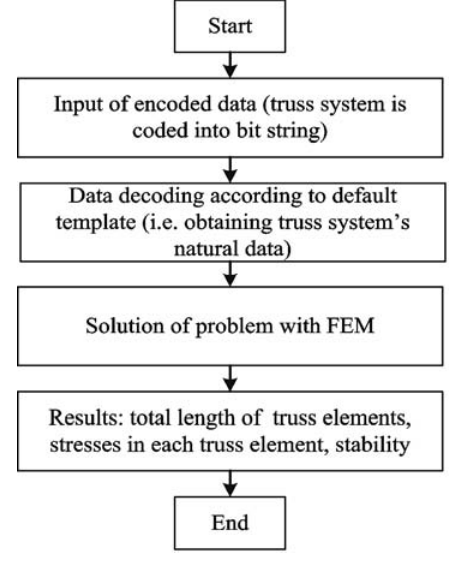
Fig. 1. Algorithm of